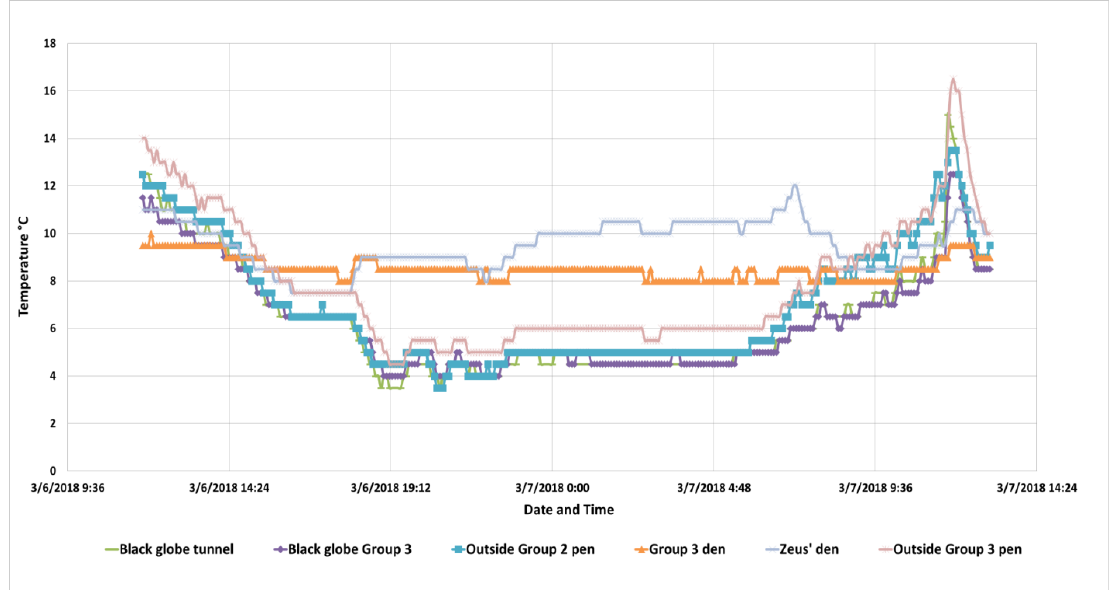
Figure 6. The six environmental temperature loggers show that the temperatures recorded within the dens remained several degrees warmer at night than outside temperatures, even though the loggers were outside of the focus of the infrared heaters within each den.